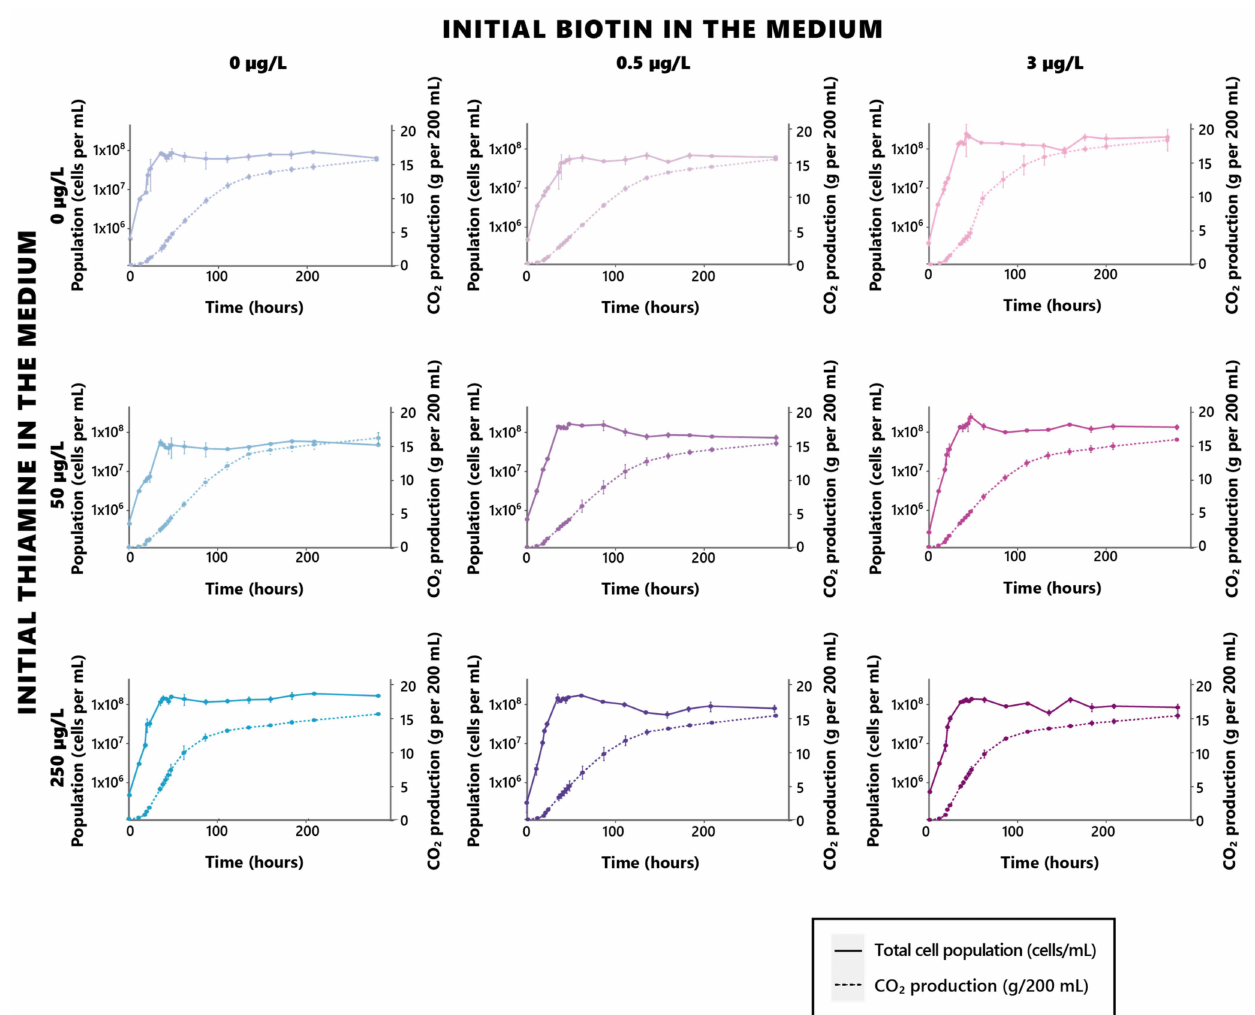
Figure 1. Growth and fermentation profiles of S. cerevisiae under different biotin and thiamine concentrations. Bluer and darker blue shades indicate higher initial thiamine in the cultivation medium, while pinker and darker pink shades indicate higher initial biotin in the cultivation